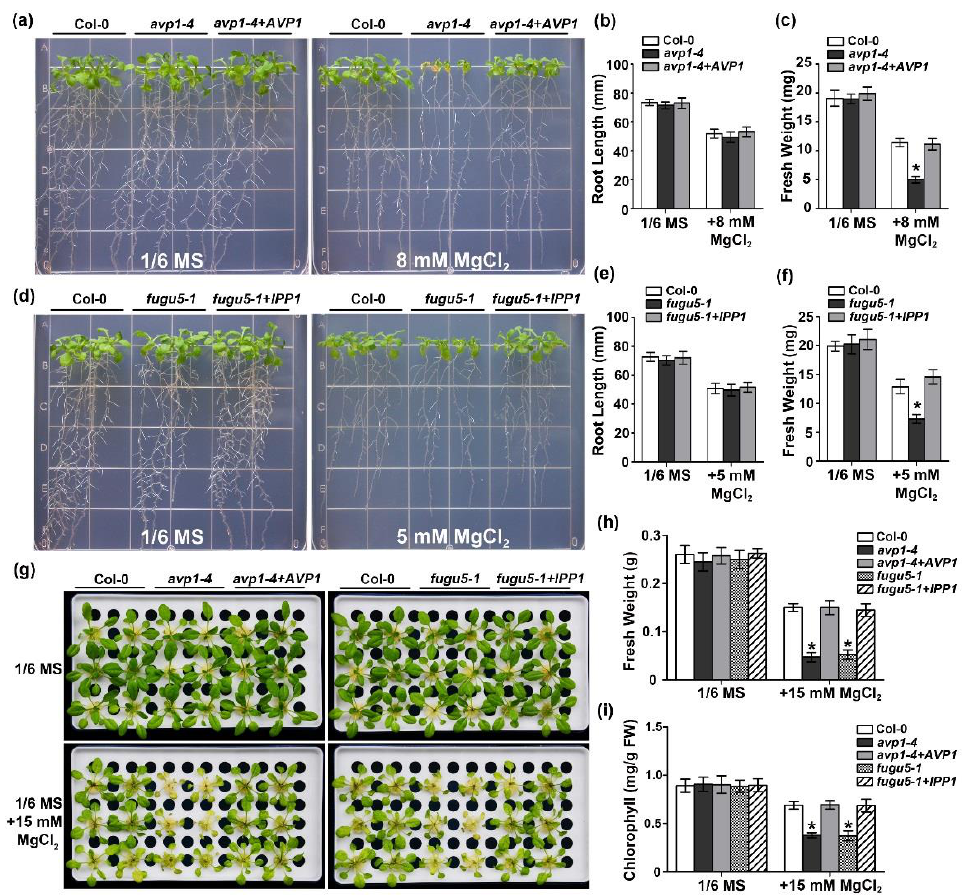
Figure 2. Functional complementation of avp1-4 and fugu5-1 under high-Mg stress grown on agar plates or in hydroponic culture. ( a ) Growth phenotype of wild type Col-0, avp1-4 and corresponding complementary line avp1-4 + AVP1 on 1/6 MS medium or 1/6 MS medium supplemented with 8